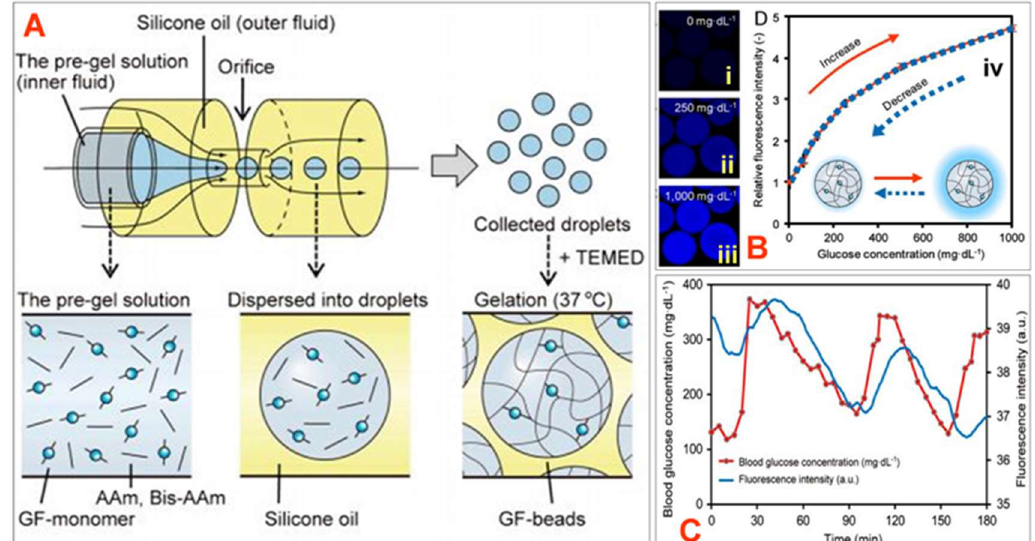
Figure 23. ( A ) Fluorescent microbeads fabricated by a microfluidic system. ( A ) Schematic diagram of the AFFD. The pregel solution flows into the inner channel of the AFFD, and the silicone oil flows into the outer channel. The droplets in silicone oil are collected from the solution with TEMED at 37 ◦ C; they turn into microbeads after gelation. ( B ) Glucose responsiveness of GF-beads. (i–iii) Fluorescent images of GF-beads at a glucose concentration of 0 mg · dL − 1 , 250 mg · dL − 1 , and 1000 mg · dL − 1 , respectively, (iv) The fluorescence intensity of GF-beads (n = 19) changes according to the increase and decrease in glucose concentration. The overlapping curves are evidence of the reversible reaction between GF-beads and glucose. ( C ) The fluorescence intensity traces blood glucose concentration. The time lag mainly comes from the time response between the interstitial fluid glucose concentration and the blood glucose concentration [68].